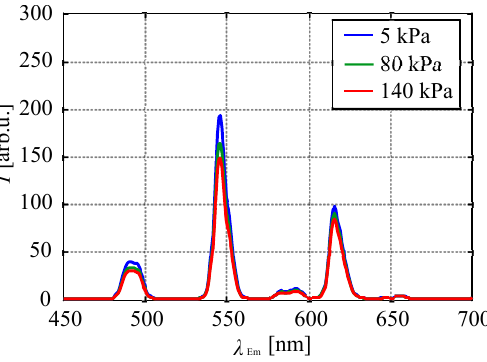
Figure 12. Effect of pressure on the emission spectrum of the chameleon luminophore in the